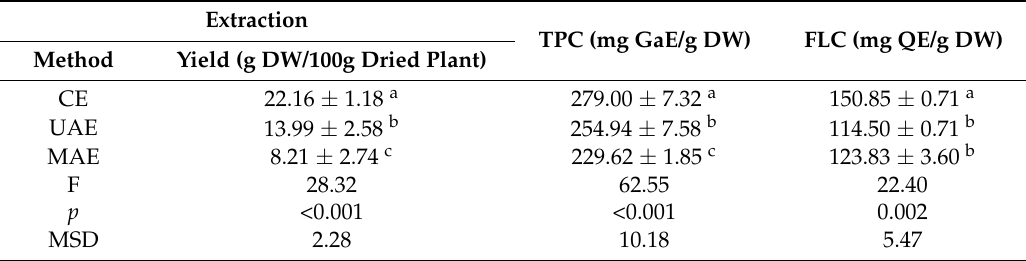
Lower case letters indicate significant differences among the extraction methods for the same column by Tukey test ( p < 0.05). CE: Conventional Soxhlet extraction; UAE: Ultrasound-assisted extraction; MAE: Microwave-assisted extraction; DW: Extract based on dried weight; GaE: Equivalent gallic acid;